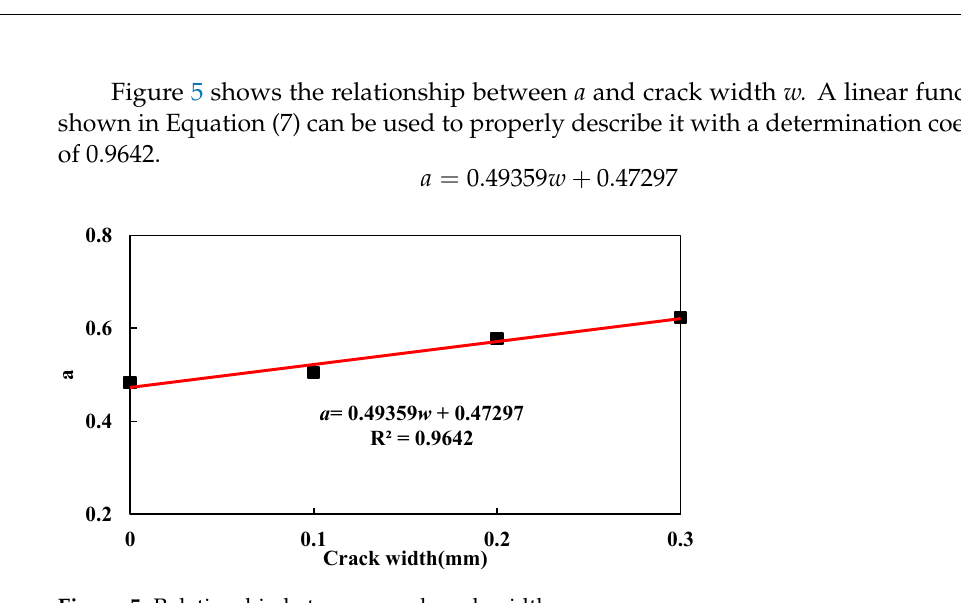
Figure 4. Influence of exposure time on surface chloride concentration.